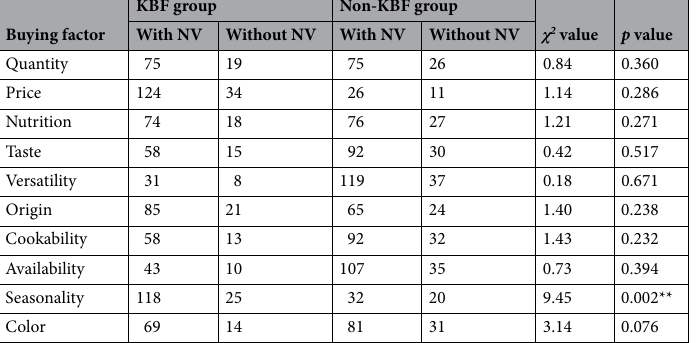
Table 3. Number of participants with and without nostalgic vegetables in the KBF and non-KBF groups for each buying factor at the time of vegetable purchase. NV: nostalgic vegetable. df (degree of freedom) = 1. ** p <